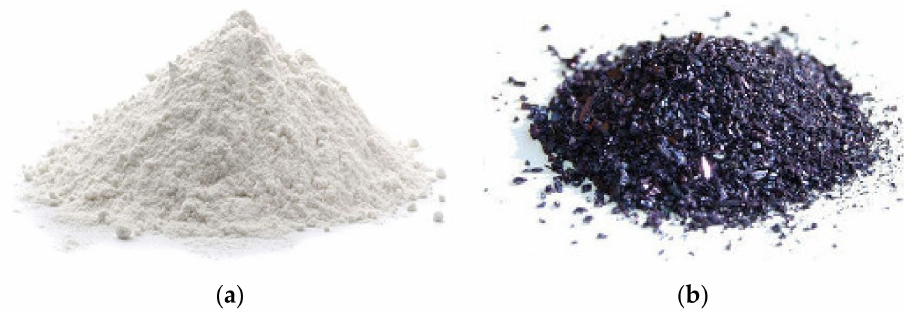
Figure 3. Catalytic additives: ( a ) calcium oxide and ( b ) potassium